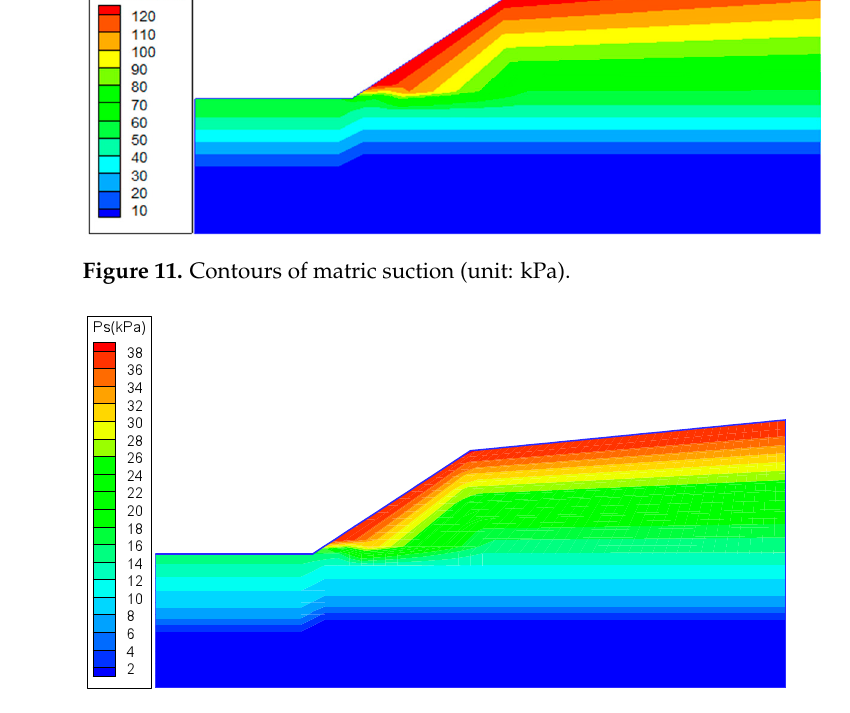
Figure 12. Contours of the equivalent expansive force (unit: kPa).